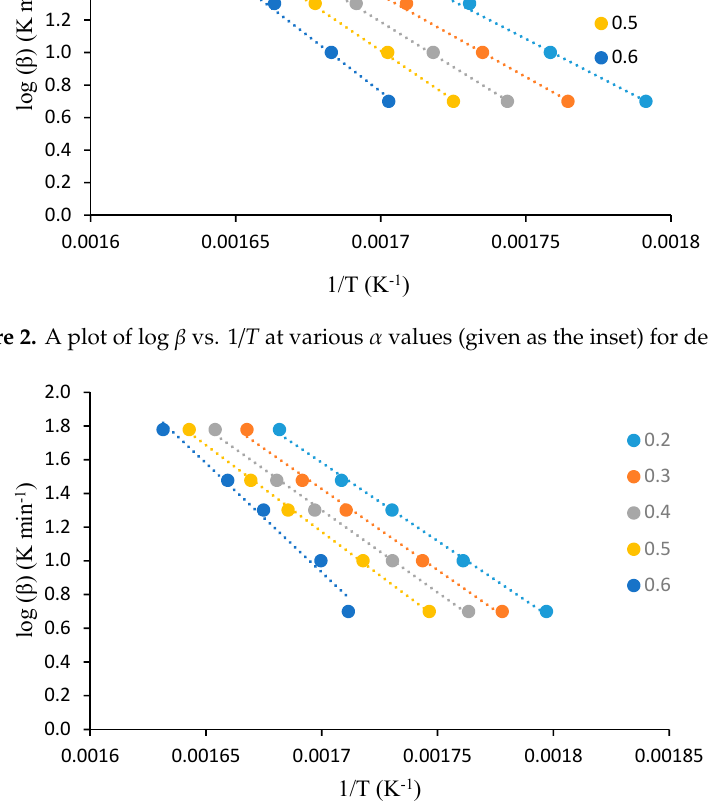
Figure 3. A plot of log β vs. 1 / T at various α values (given as the inset) for potato Figure 3. A plot of log β vs. 1/ T at various α values (given as the inset) for potato starch. Figure 3. A plot of log β vs. 1/ T at various α values (given as the inset) for potato starch. Figure 3. A plot of log β vs. 1/ T at various α values (given as the inset) for potato starch.